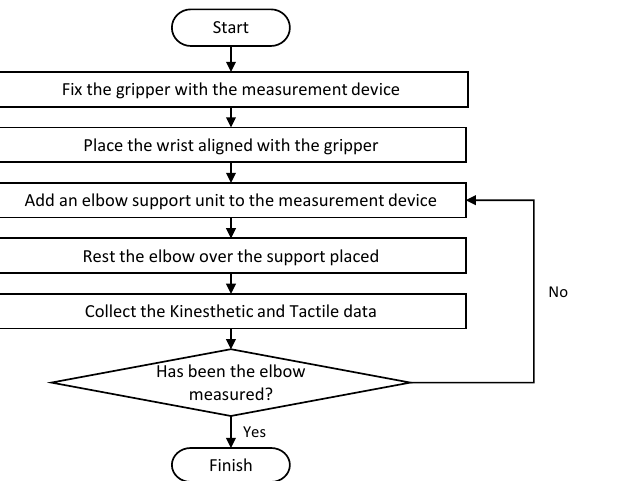
Figure 4. Flowchart of the steps needed to record a full haptic dataset using the forearm measurement